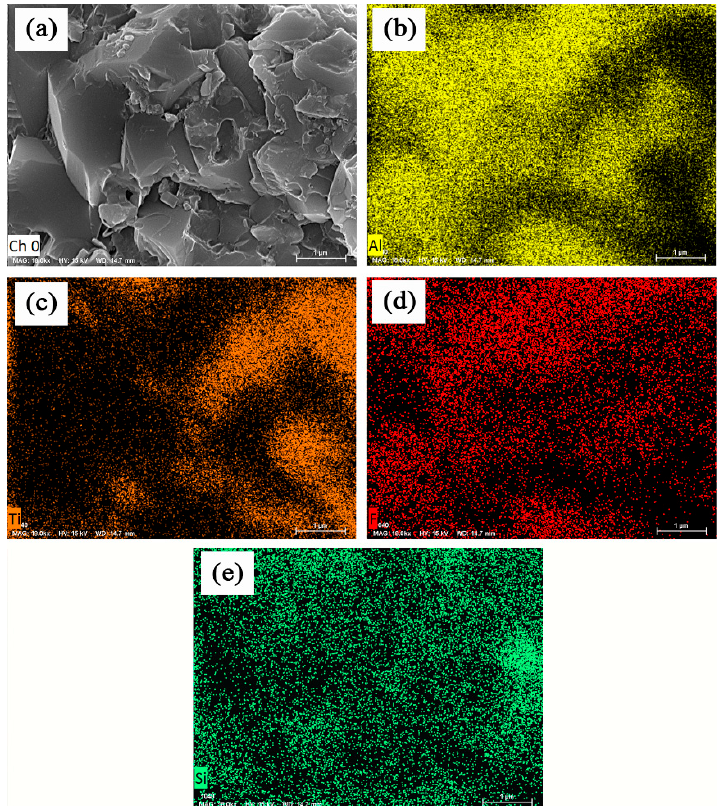
Figure 6 . SEM micrograph and EDS spectra of fracture surfaces of Al 2 O 3 /TiC/CaF 2 @SiO 2 self- Figure 6. SEM micrograph and EDS spectra of fracture surfaces of Al 2 O 3 / TiC / CaF 2 @SiO 2 self-lubricating lubricating ceramic composites: ( a ) fracture morphology of Al 2 O 3 /TiC/CaF 2 @SiO 2 ceramic composites ceramic composites: ( a ) fracture morphology of Al 2 O 3 / TiC / CaF 2 @SiO 2 ceramic composites ( b ) Al ( b ) Al element ( c ) Ti element ( d ) F element ( e ) Si element. element ( c ) Ti element ( d ) F element ( e ) Si